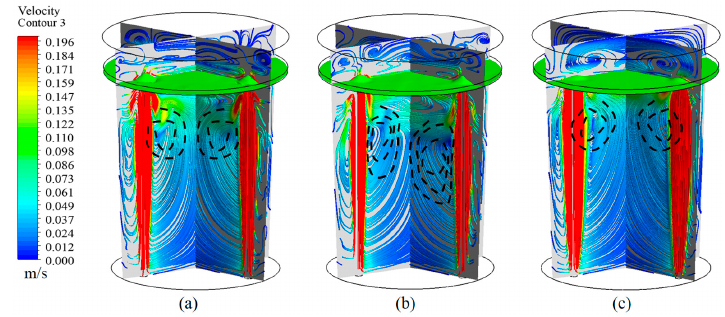
Figure 11. Velocity and streamlines in the ladle with different plugs: ( a ) S ‐ S mode, ( b ) S ‐ P mode, and ( c ) P ‐ P mode.